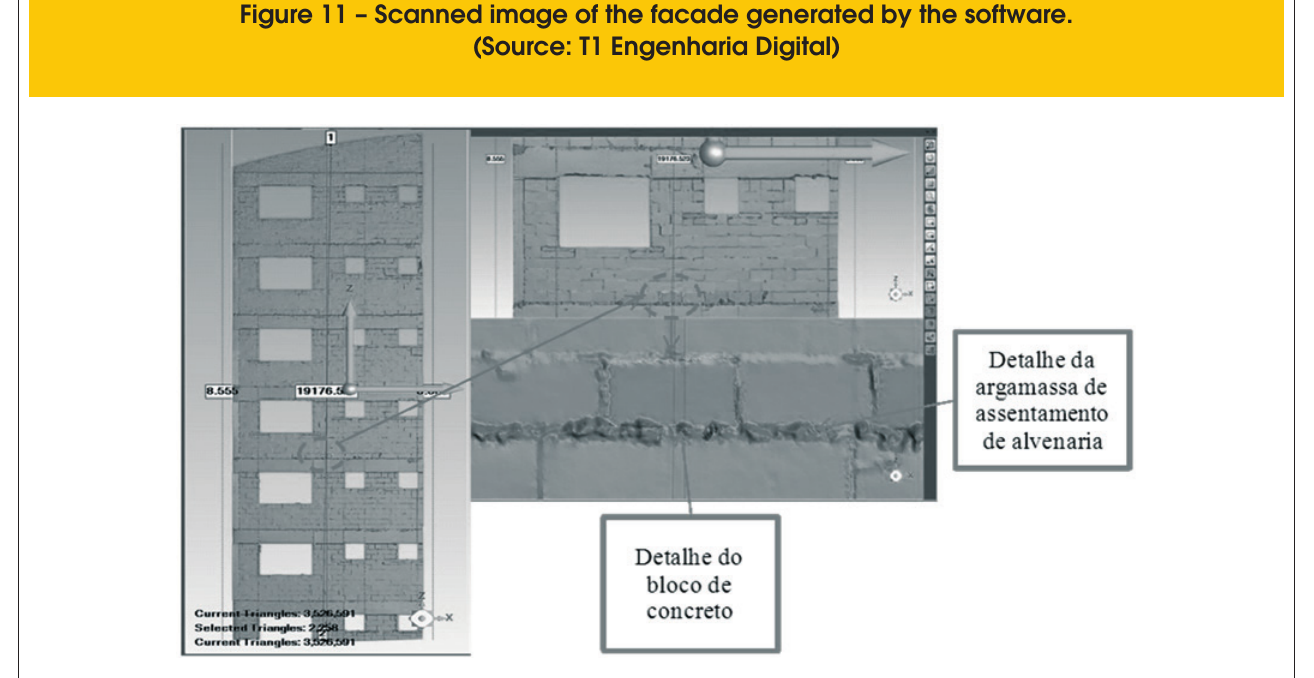
Figure 11 – Scanned image of the facade generated by the